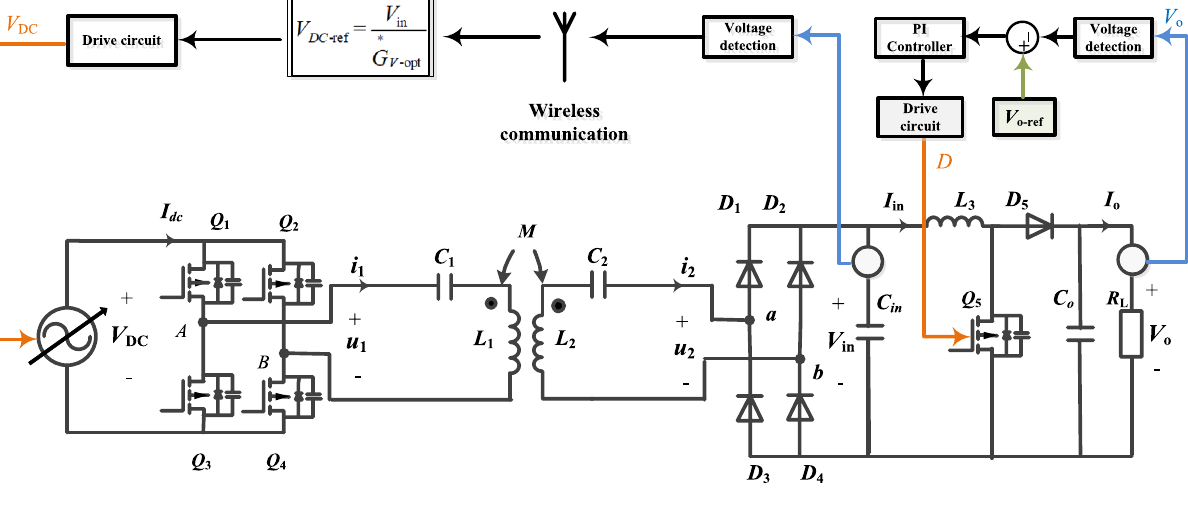
Figure 8. System control loop